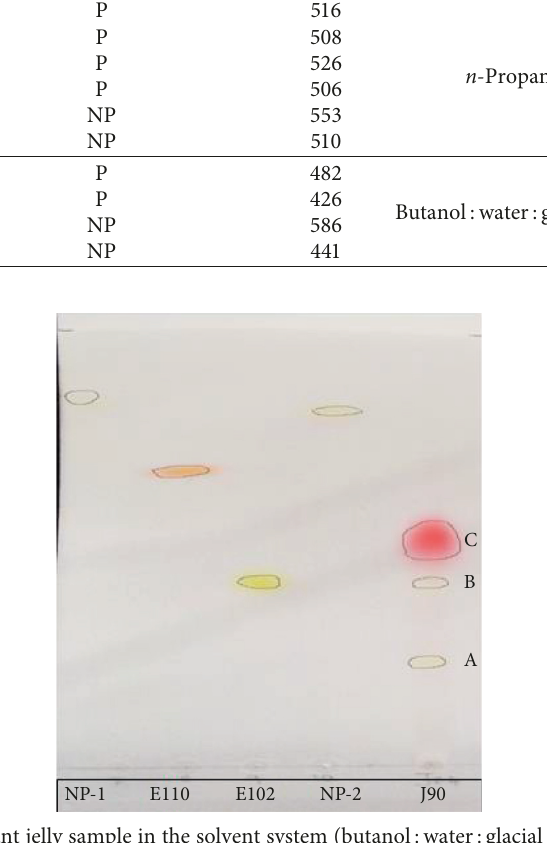
Table 2: TLC and spectrophotometric analysis of some nonpermitted and all permitted synthetic red and yellow food colour standards. Colour standard